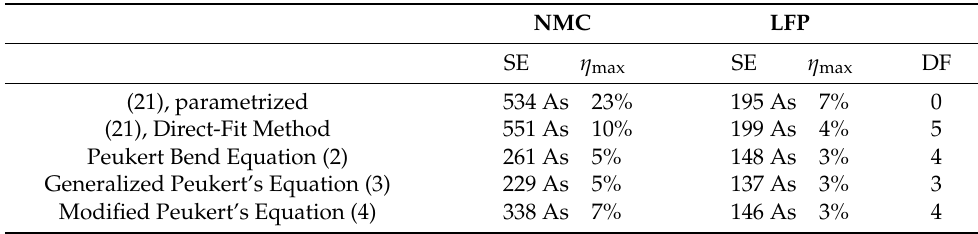
Table 2. Statistics comparing the parametrized equations on available charge with experimental